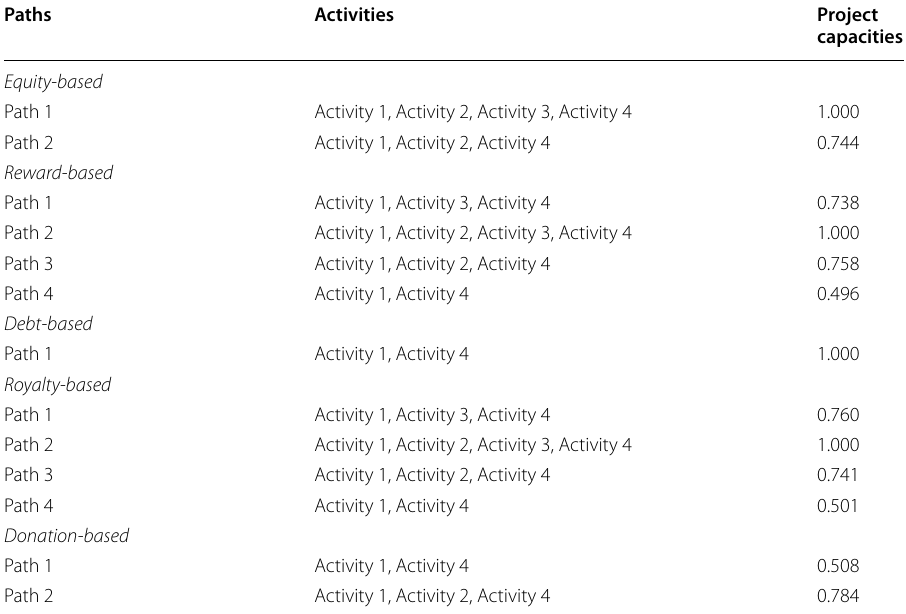
Table 22 The project paths and capacities for the service development in clean energy investment projects by the crowdfunding alternatives